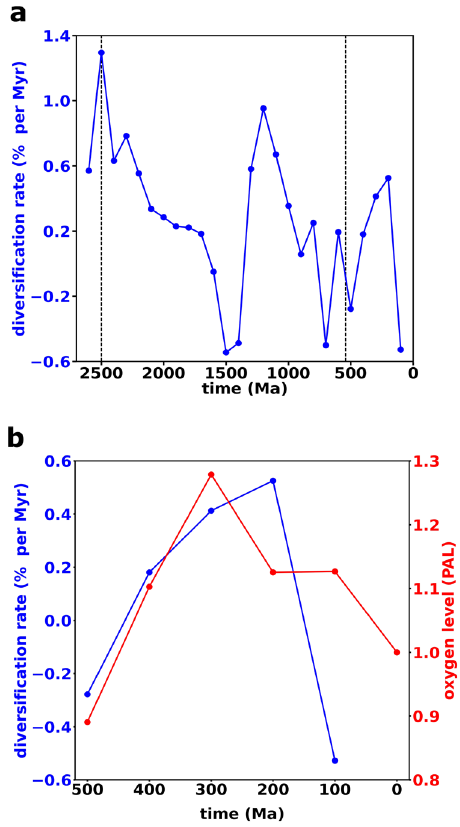
Fig. 4 Diversi fi cation of SAR202 Baeyer – Villiger monooxygenase (BVMO) genes and its temporal correlation with the evolution of Earth ’ s atmospheric O 2 levels. a Evolution of the per-gene diversi fi cation rate of the SAR202 BVMO genes over geologic time. The two vertical dashed lines represent the Archean/Proterozoic boundary and Proterozoic/Phanerozoic boundary, respectively. Three positive peaks stand out, during the Neoarchean/Paleoproterozoic (around 2500 Ma), the Middle/Late Mesoproterozoic (around 1200 Ma), and the Late Paleozoic/Early Mesozoic (around 300 – 200 Ma), corresponding, respectively, to the time of the Great Oxidation Event, the rapid divergence of eukaryotic marine algae, and the Permo-Carboniferous O 2 pulse. b The temporal correlation between the SAR202 BVMO diversi fi cation rate (blue) and Earth ’ s atmospheric O 2 level (red) in the Phanerozoic. The red dots from 100 Ma to 500 Ma are the moving averages of the O 2 levels in 45 , using an averaging window of 200 Myr, which is the uncertainty range (i.e., 95% con fi dence interval) of the age distributions in the Phanerozoic on the gene tree chronogram of BVMO homologs (Supplementary Fig. 4). The O 2 concentration at time 0 is the present atmospheric level strongly protected by the newly accumulated iron(III) minerals, thereby enhancing the accumulation of atmospheric O 2 . The combination of these factors explains the correlation of the initial diversi fi cation of the SAR202 BVMO genes with the GOE and the Lomagundi Excursion Event.